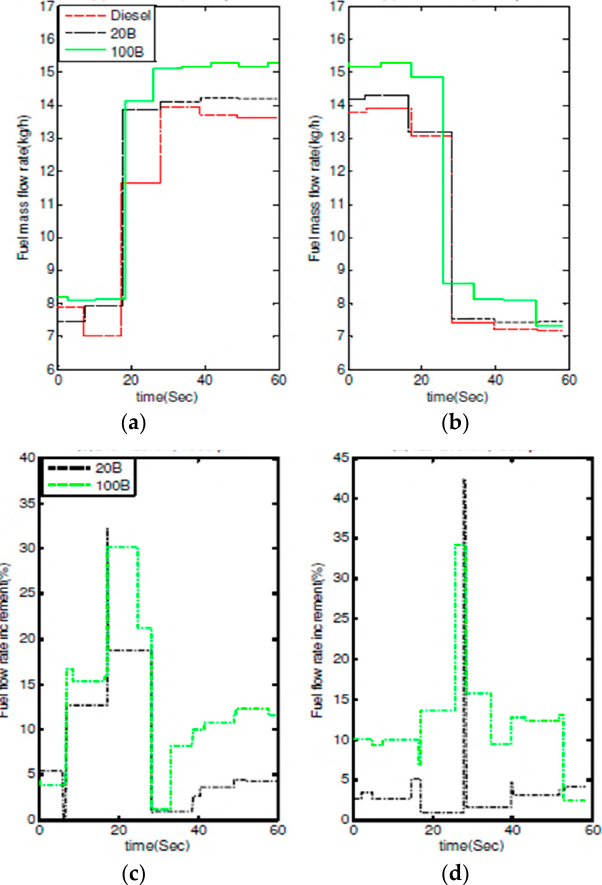
Figure 4. ( a , b ) CI time response during positive and negative torque transition at 420 Nm using biodiesel and ( c , d ) the corresponding fuel flow rate percentage increment at positive and negative torque transition respectively.